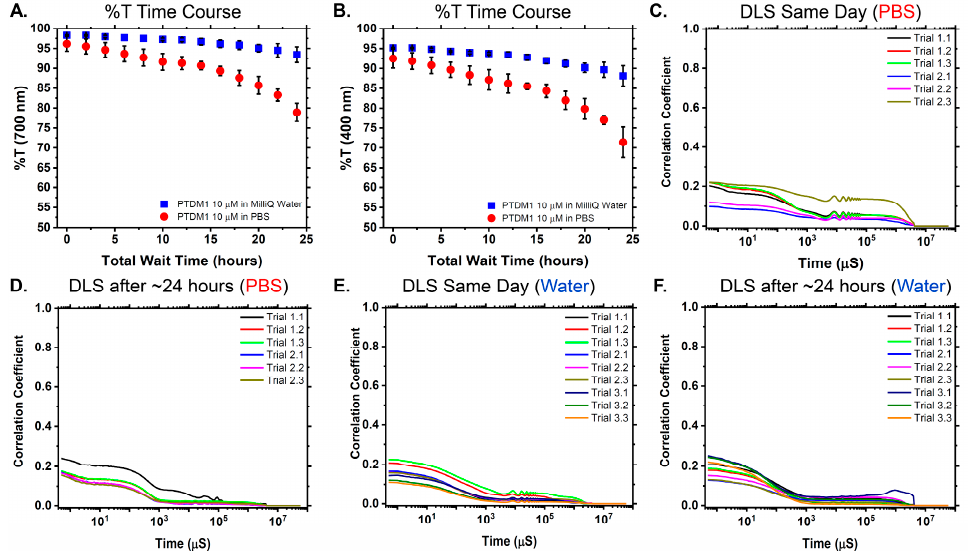
Figure 4. Characterization of PTDM1 in aqueous solutions using transmittance (%T) assays and dynamic light scattering (DLS). ( A ) %T of 700 nm light through solutions containing PTDM1 at 10 µ M in both Milli-Q ® water (blue squares) and PBS (red circles). Results obtained are the average of two independent trials where the average %T is plotted and the error bars represent ± one standard deviation. ( B ) %T of 400 nm light through the same solutions containing PTDM1 at 10 µ M in both Milli-Q ® water (blue squares) and PBS (red circles). Results obtained are the average of two independent trials where the average %T is plotted and the error bars represent ± one standard deviation. ( C ) DLS correlation coefficient plots for two independent trials of PTDM1 at 10 µ M in PBS where each trial run was comprised of three measurements. Each sample was prepared immediately before the experiment. ( D ) DLS correlation coefficient plots from two independent trials of PTDM1 at 10 µ M in PBS